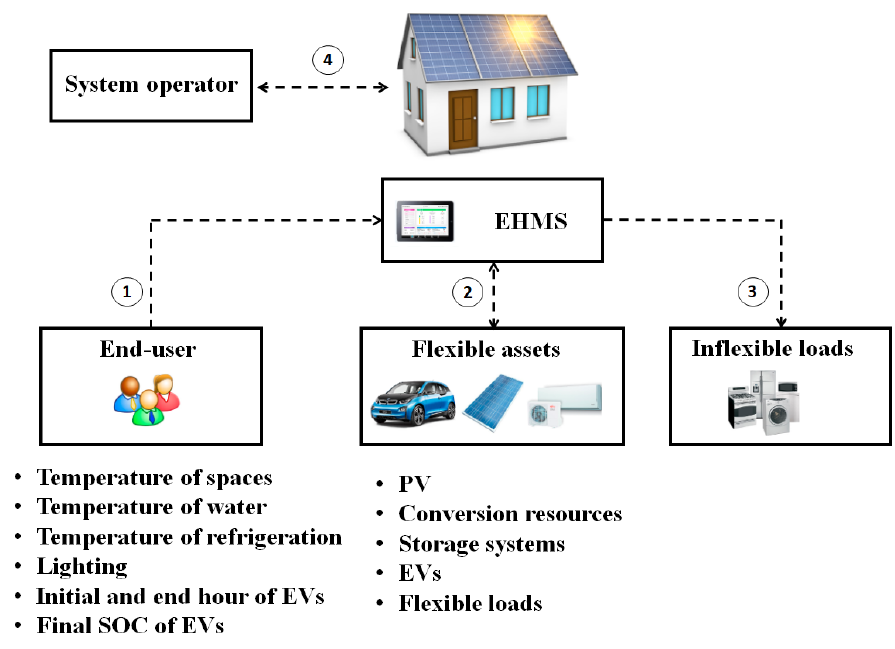
Figure 2. Energy hub management system scheme, adapted from